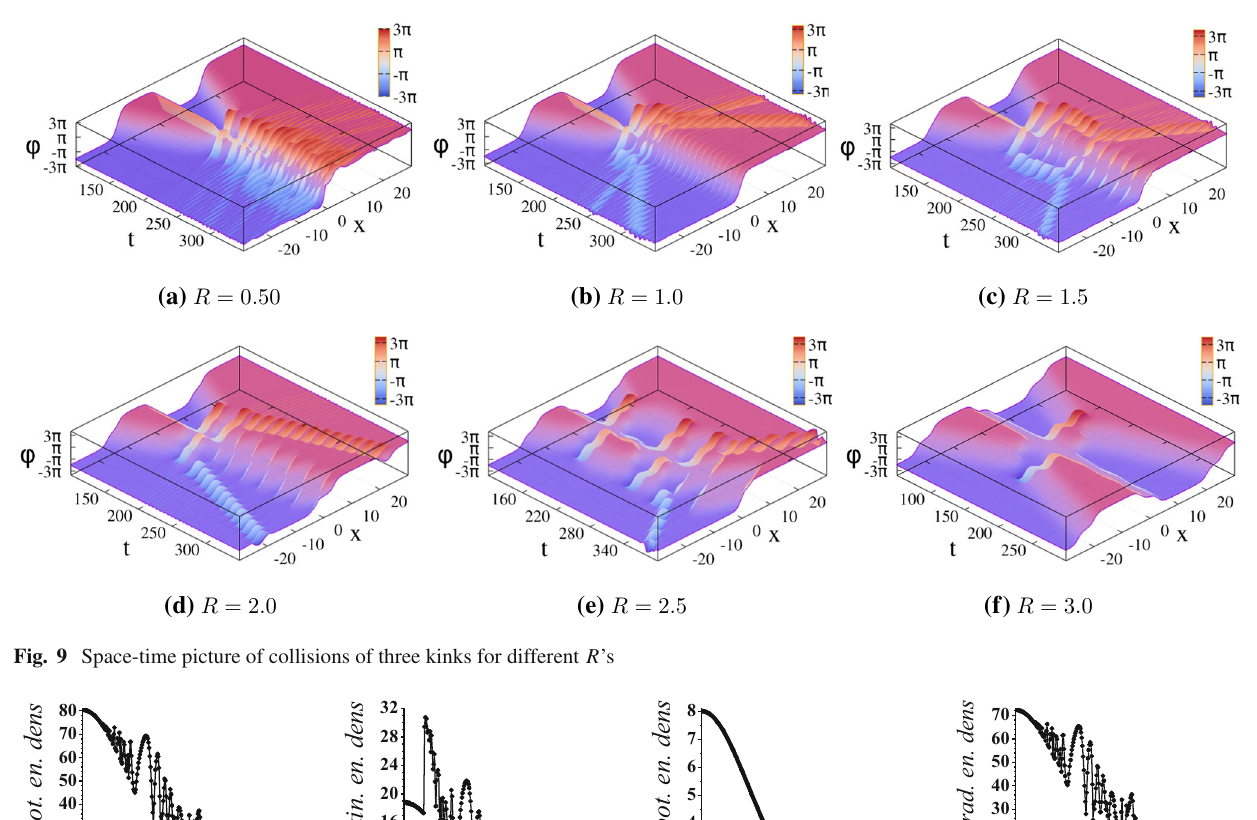
0.0 0.5 1.0 1.5 2.0 2.5